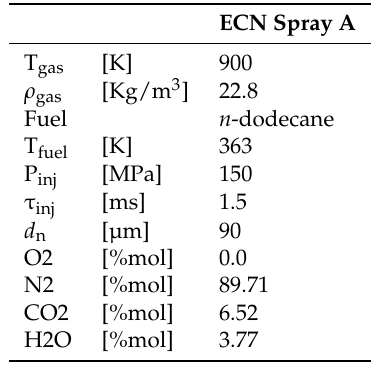
Figure 2. Computational domain of the studied LES (dimensions in mm). Refinement layers are indicated by R1, R2, R3 which correspond to cell sizes of 1000, 250, 62.5 µm respectively. Table 1. Operating conditions based on ECN Spray